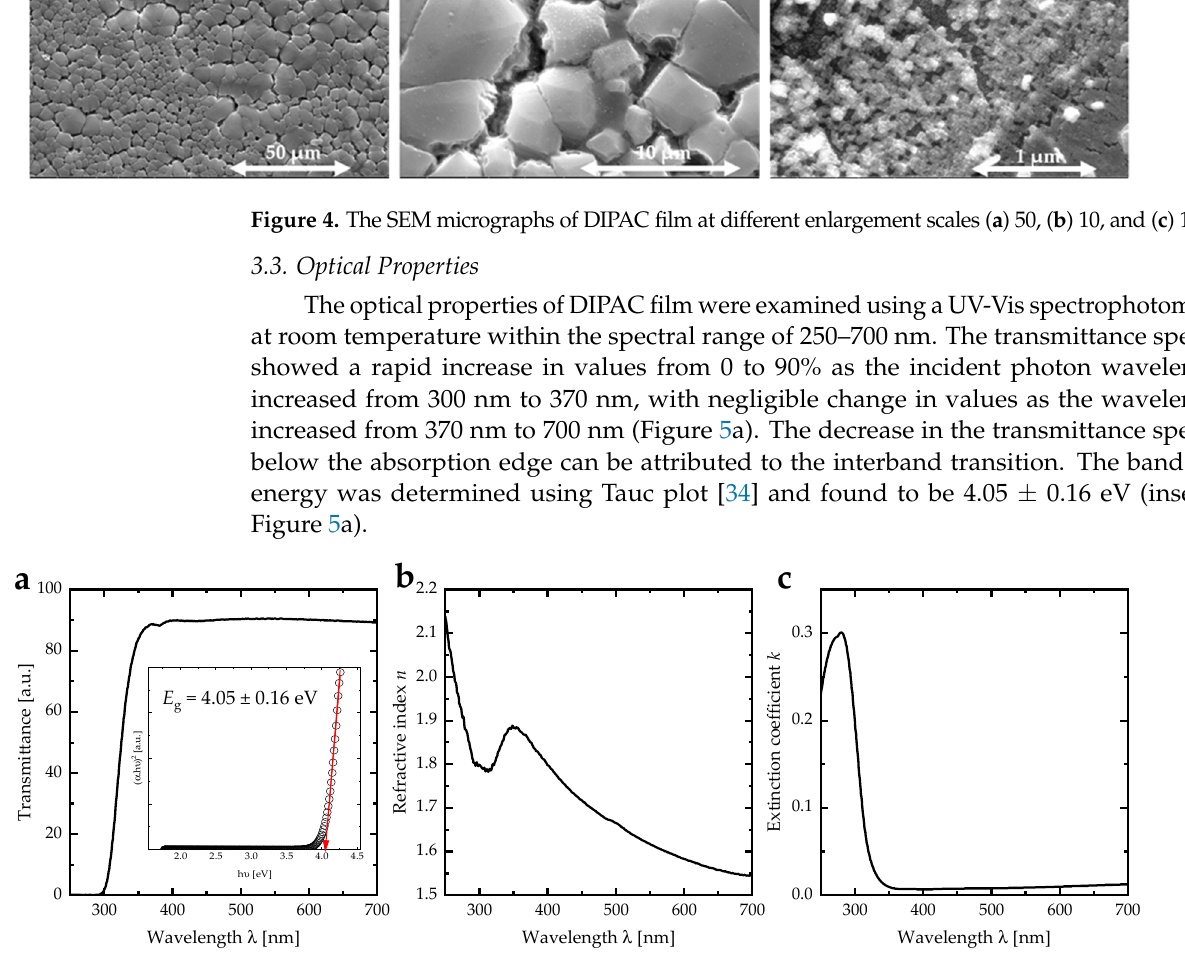
Figure 5. ( a ) Transmittance, ( b ) refractive index, and ( c ) extinction coefficient of DIPAC film. The inset in Figure 5a represents the Tauc plot of DIPAC fi lm.